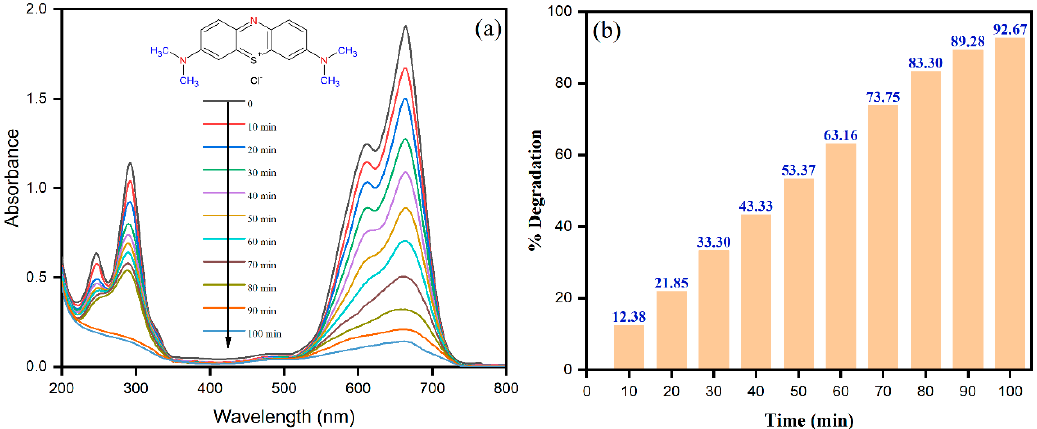
Figure 9. ( a ) Ultraviolet–visible (UV–vis) spectra of the degradation of methylene blue (MB), ( b ) % degradation of MB dye with respect to irradiation time.